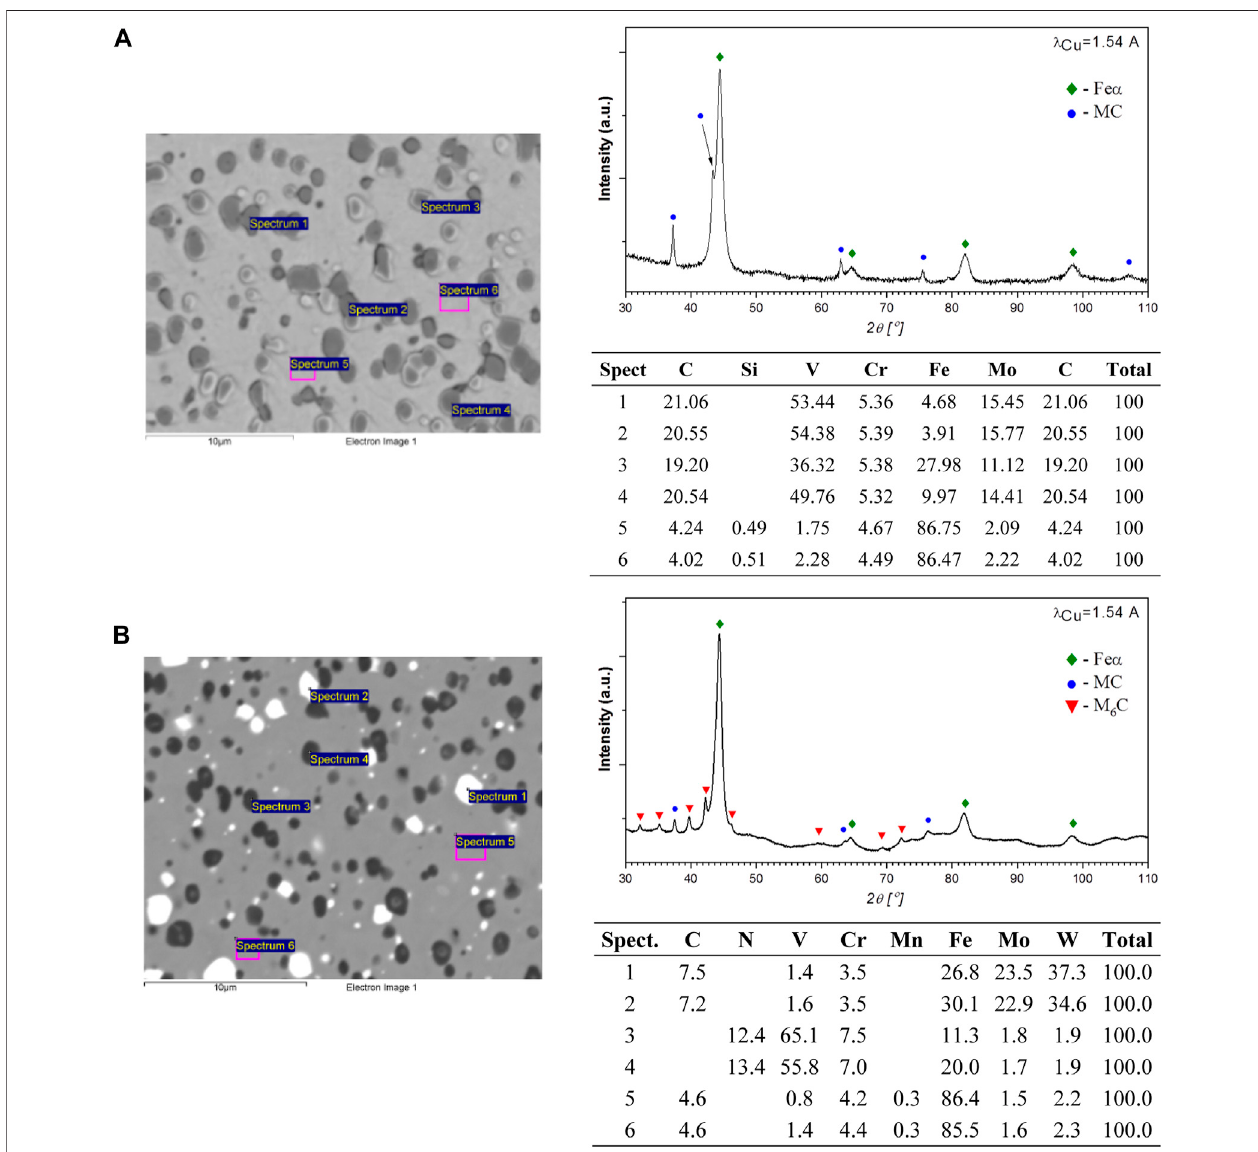
FIGURE 4 | XRD patterns and microstructure with EDS analysis of two studied steels: (A) Vanadis 8, (B) Vancron 40.